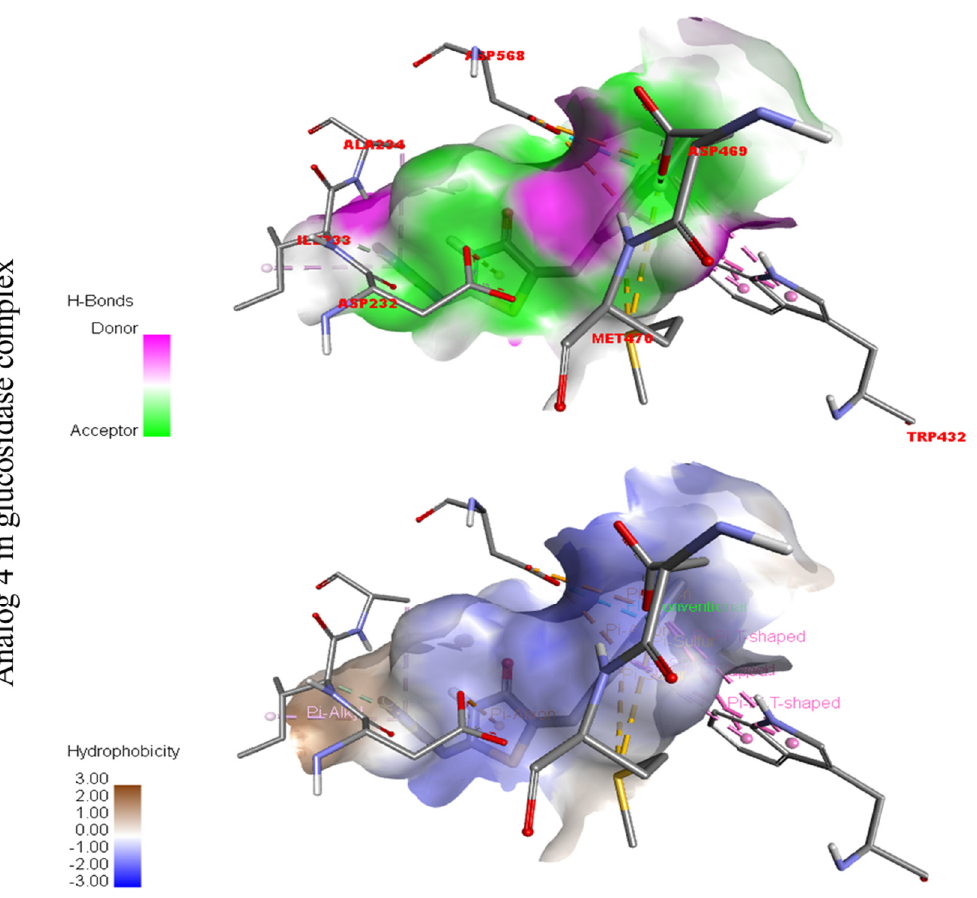
Figure 5. Represent hydrogen bond and hydrophobic character against Alpha-glucosidase indicate the PLI profile for compound 4.